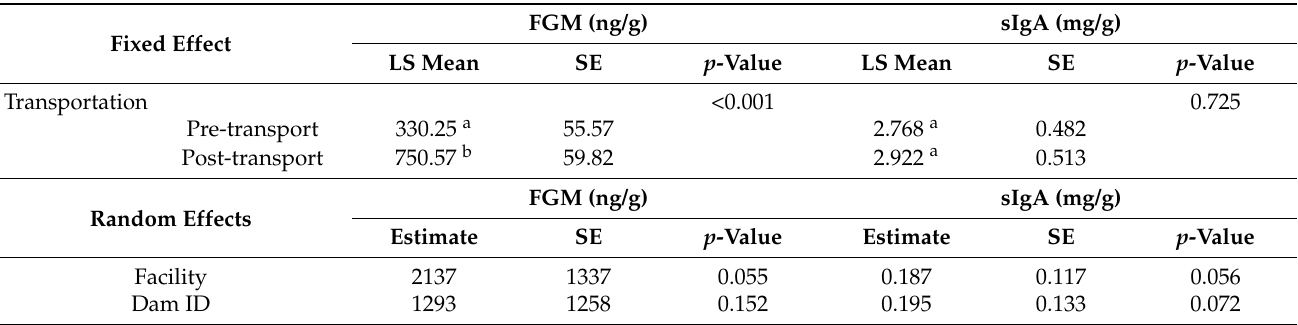
Figure 2. Descriptive statistics of the variation in focal puppies’ FGM (ng/g) and sIgA (mg/g) concentrations among facilities, pre- and post-transportation. Differences of FGM ( A ) and sIgA ( B ) concentrations among facilities within and between time points (i.e., blue bars = pre-transportation: puppies of 8-week of age assessed at the CBK; orange bars = post-transportation: puppies assessed 48 h after arrival to the distributor). Table 5. Effect of transportation, facility, and Dam ID on litter FGM (ng/g) and sIgA (mg/g) ( n = 79